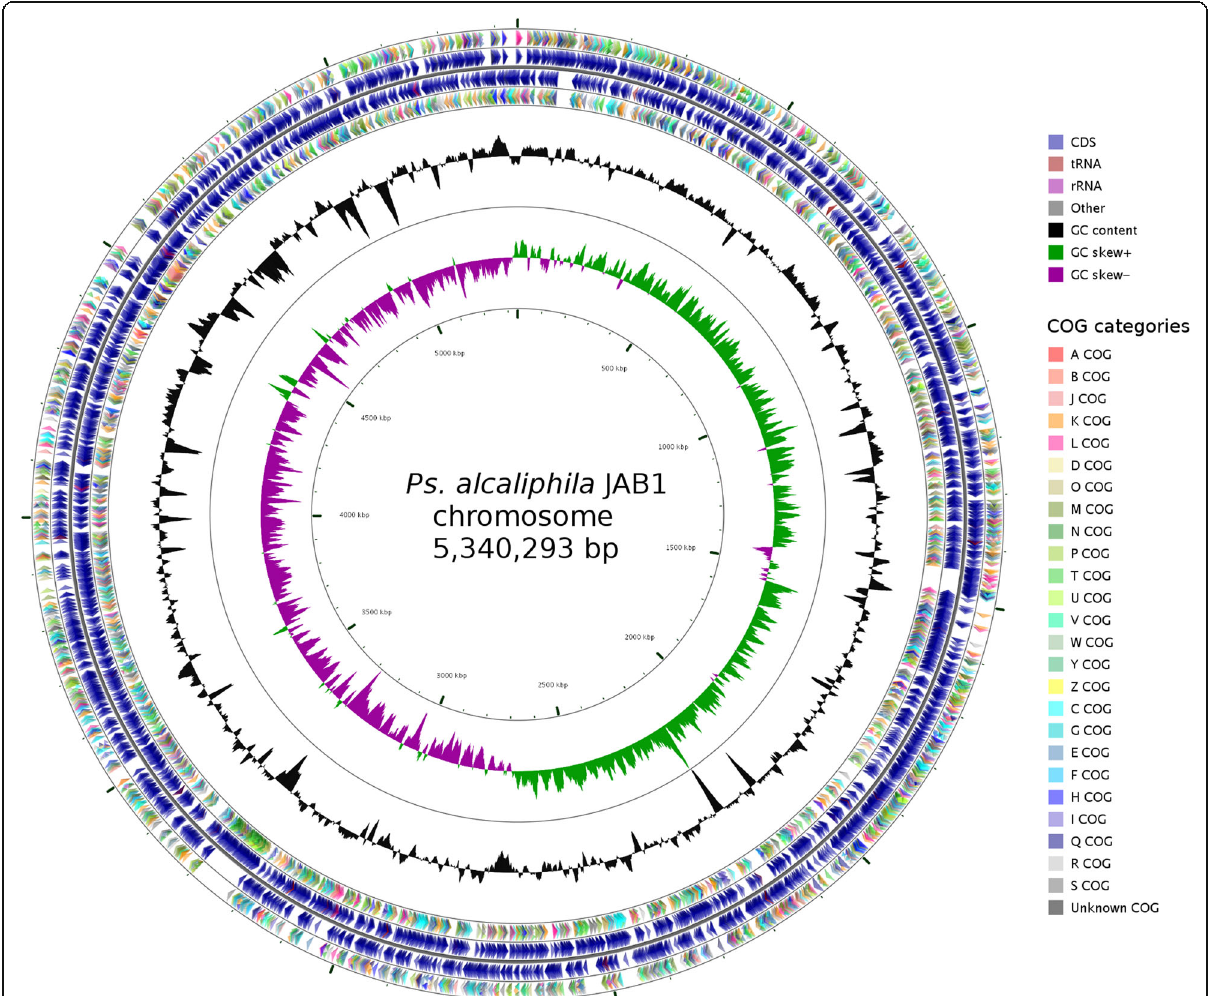
Fig. 6 Circular map of the P. alcaliphila JAB1 chromosome. From outside to the center: CDS on forward strand colored according to their COG categories, all CDS and RNA genes on forward strand, all CDS and RNA genes on reverse strand, CDS on reverse strand colored according to their COG categories, GC content, and GC skew. The map was generated using CGView